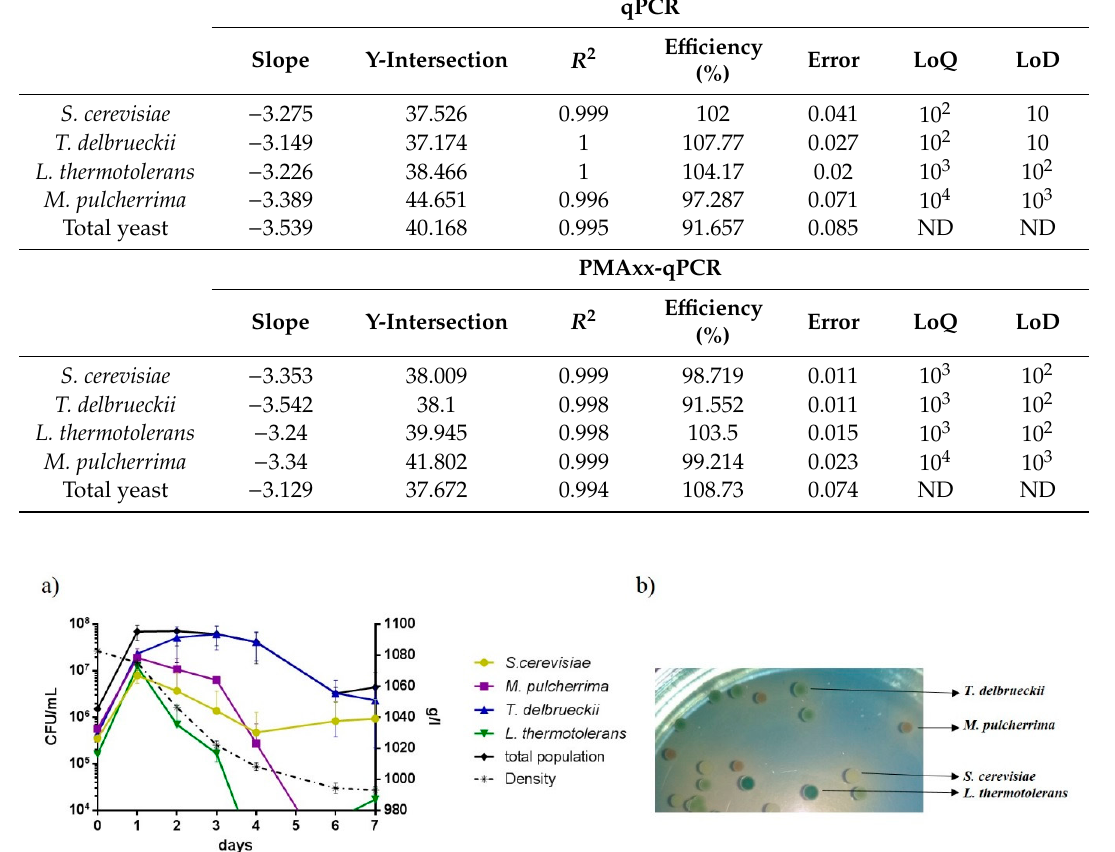
Figure 2. ( a ) Density (g / L) and viable population (CFU / mL) dynamics during fermentation. The total population was determined by plating on YPD medium and the viable population for each strain was determined by plating on WLN medium. The results are expressed as the mean ± SD of three fermentations. ( b ) Colony morphologies of the four species on WLN plates.